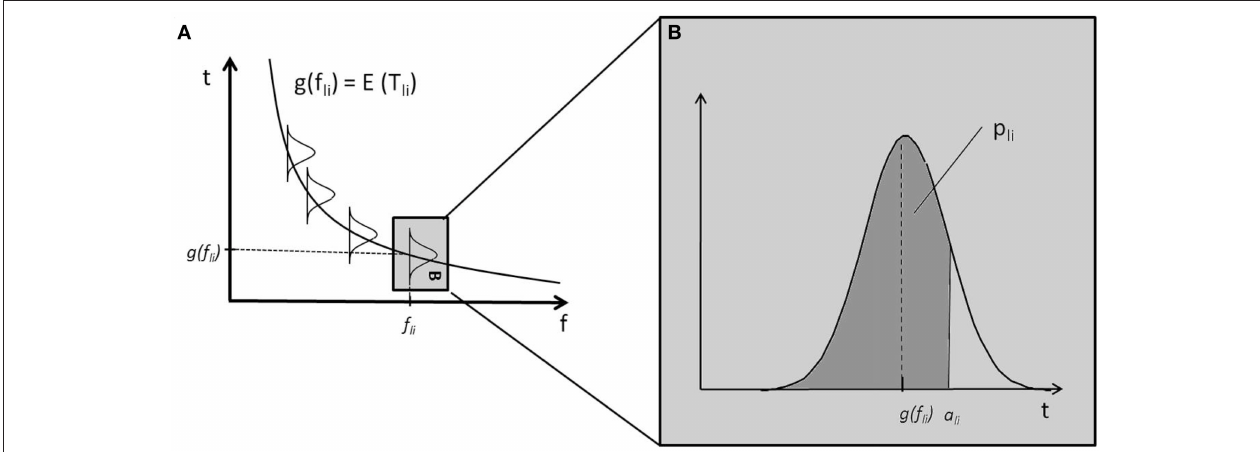
FIGURE 4 | Example of a monotonically decreasing threshold function g and sketched distributions of threshold values (A) ; the distribution of T li corresponding to the g ( f li ) gray box in (A) , enlarged in (B) ; the probability that the component c li is not filtered, p li , is the area under the component c li has an expected value µ t = a li (the dark gray area in B probability density function of T li for t ≤